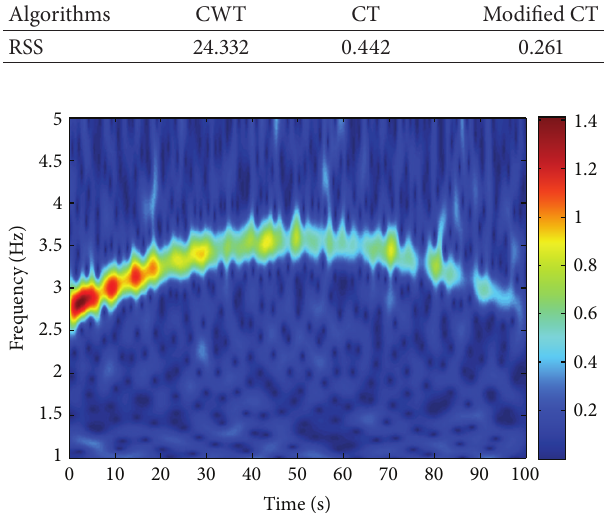
Table 1: RSS of different identification results of case 2.